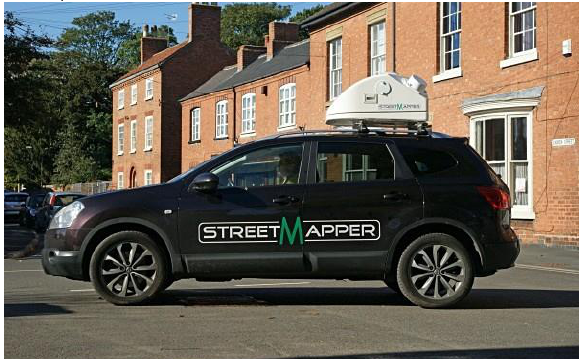
Figure 1: StreetMapper Mobile Mapping Vehicle